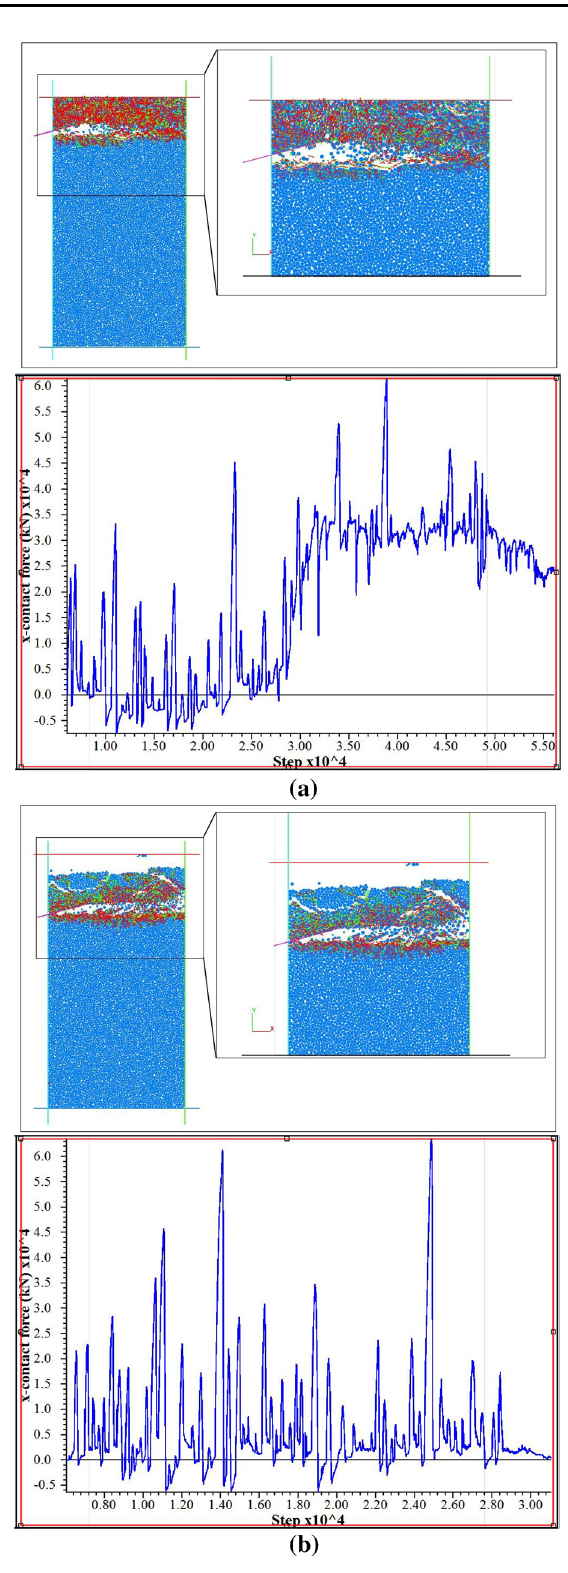
Fig. 9 Results of plow model with zero-degree angle: a Model 5, b Model 6